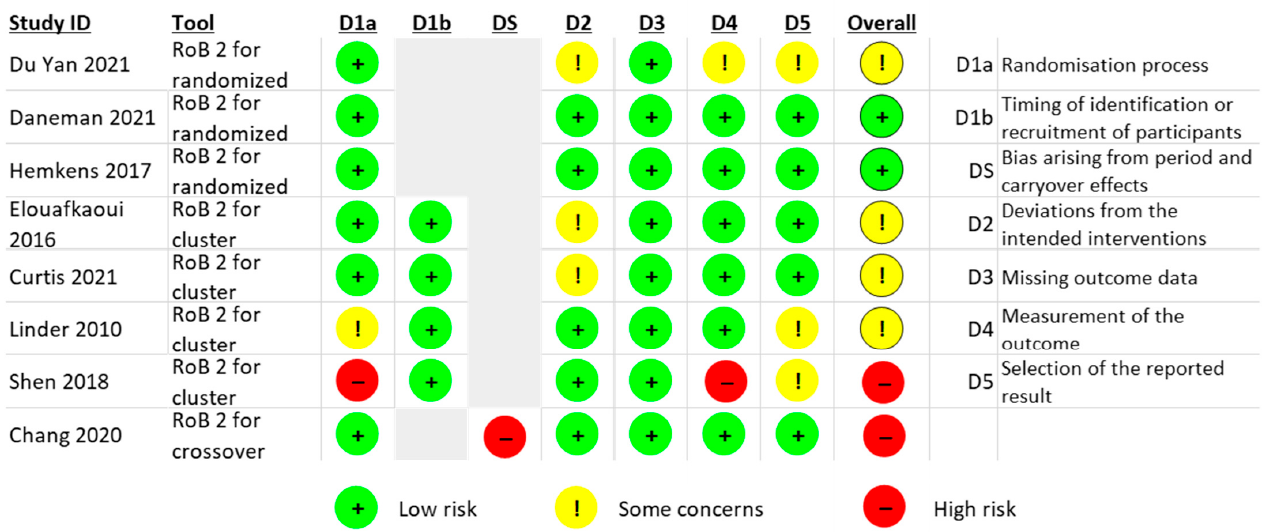
Figure 4. Risk of bias (RoB) summary. Source: elaborated by the